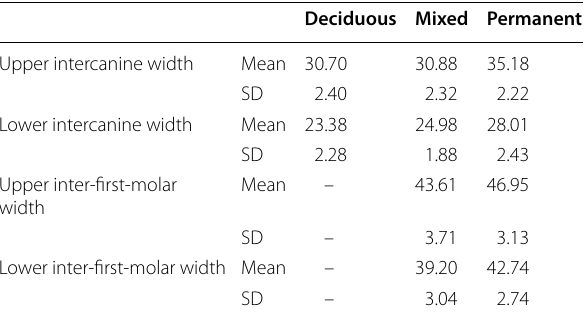
Table 2 Mean, standard deviation of upper and lower intercanine width and inter‑first‑molar width in primary, mixed,